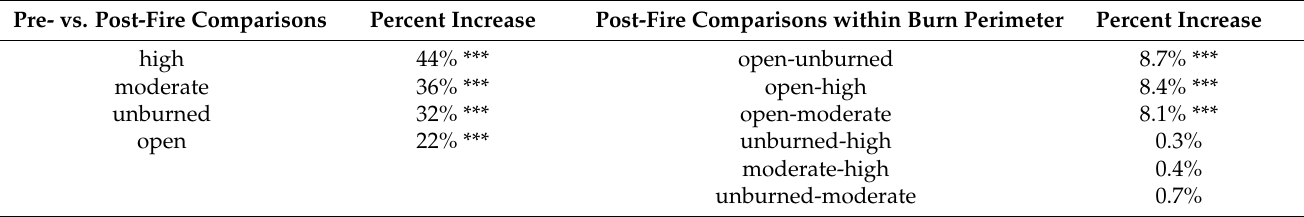
Table 3. Post-fire comparisons of percent LSA increase relative to burn severity classification, and pre- vs. post-fire comparisons of percent LSA increase relative to burn severity. Results from the daily normalized LSA Tukey Honestly Significant Difference test based on the piecewise compari- sons of burn severity classification in post-fire comparisons and pre- vs. post-fire comparisons. *** = p -value < 0.001.